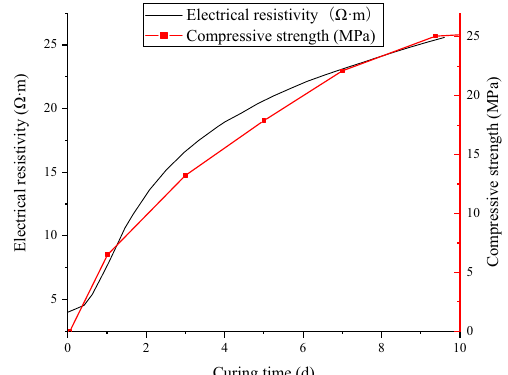
Figure 4. Resistivity growth curve and compressive strength curve of concrete under curing conditions of 20